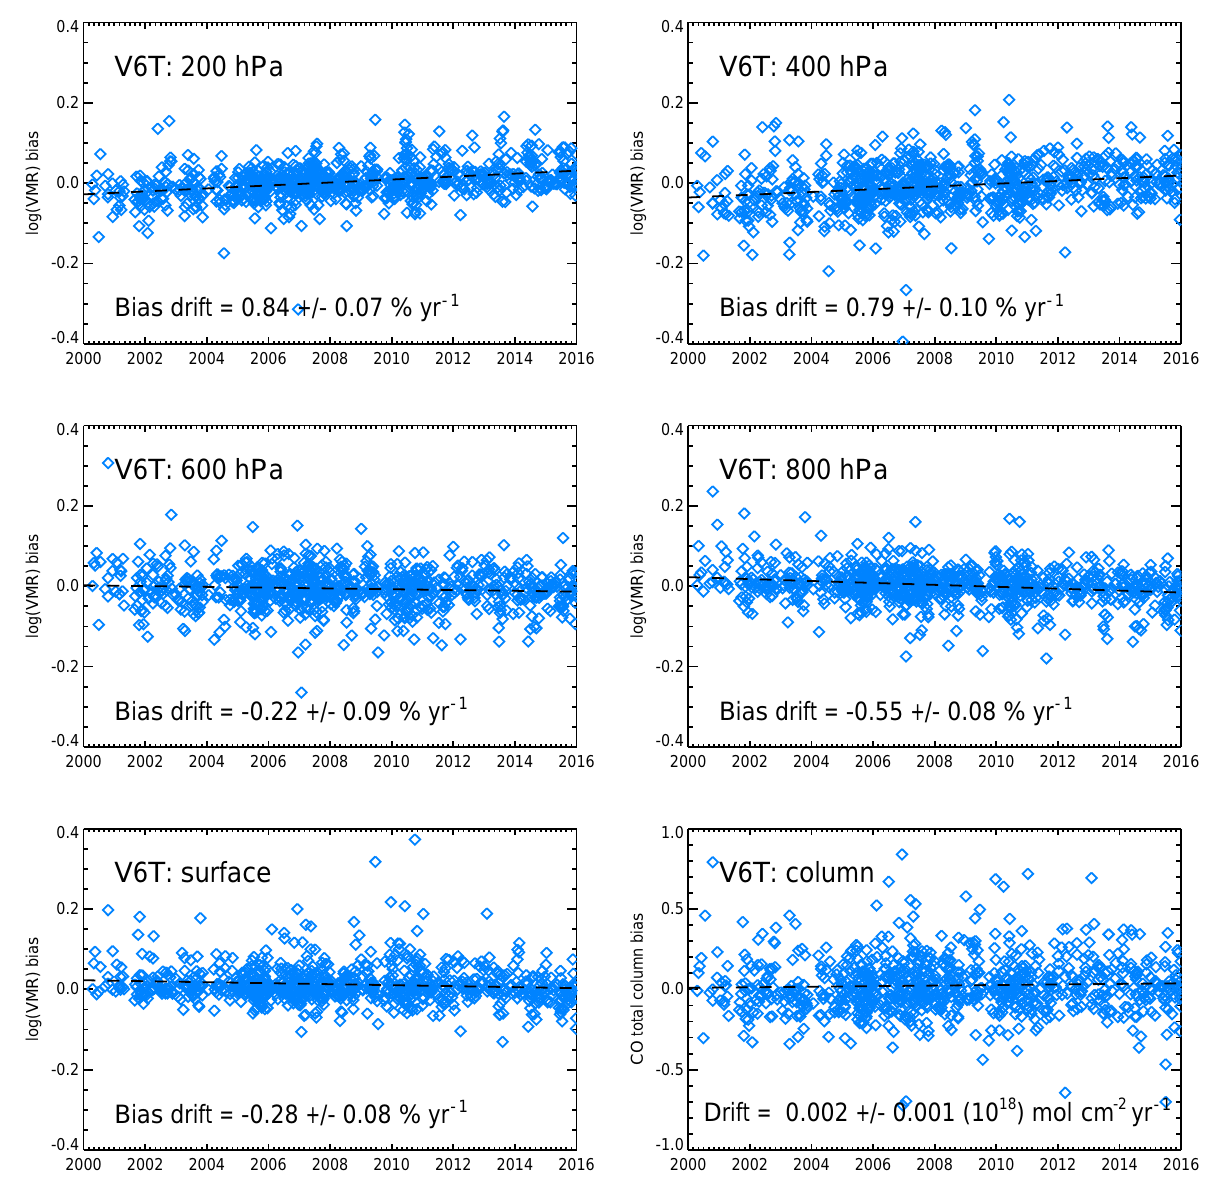
Figure 11. Retrieval bias drift for V6 TIR-only products based on the NOAA flask measurements. CO total column bias values are given in units of 10 18 moleccm − 2 . Table 2. Summarized validation results for V6T and V7T products based on in situ data from the HIPPO field campaign. See caption to Table 1. Total column Surface 800hPa